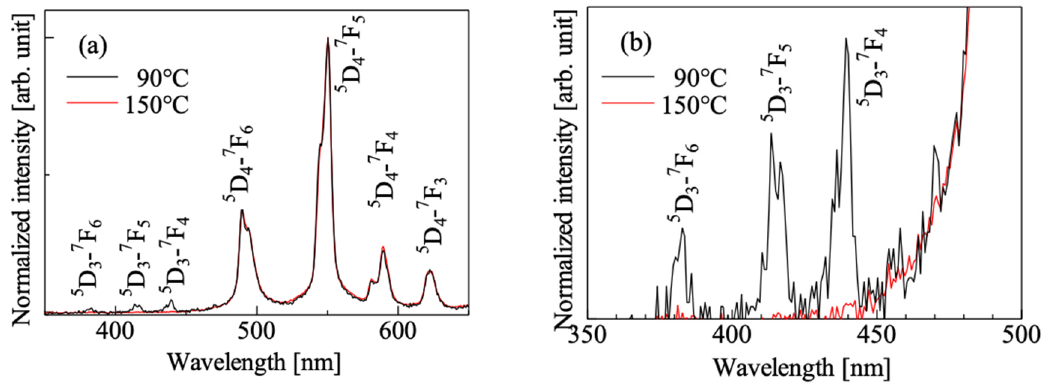
Figure 7. ( a ) TSL spectra of 3% Tb-doped MgGa 2 O 4 stimulated by 90 and 150 °C after X-ray irradiation with 10 Gy; ( b ) shows enlarged view between 350 and 500 nm.